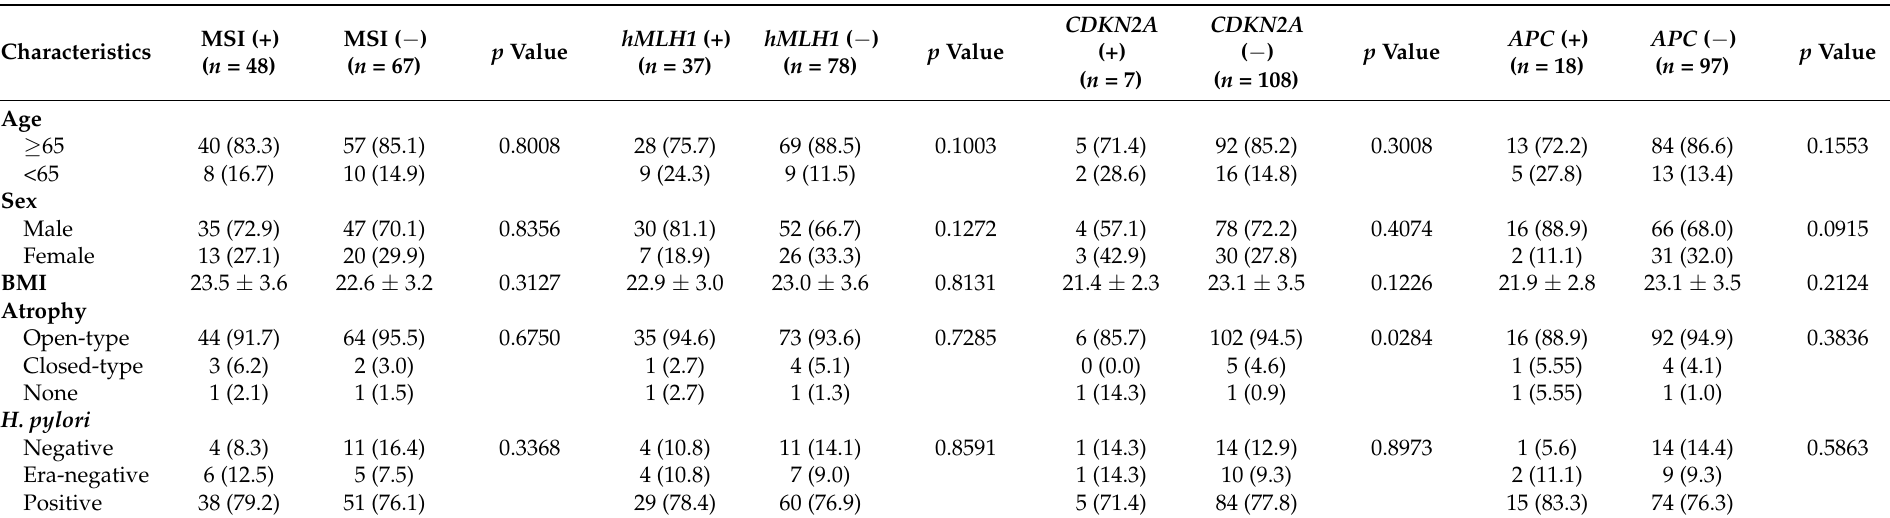
Table 2. Comparison of clinical features between patients with and without MSI or methylation of tumor suppressor